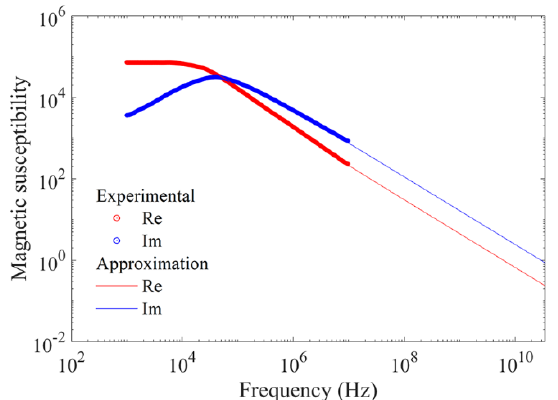
Figure 4. Frequency dependences of transmission and reflection coefficients: for the composite with 30% flakes in the frequency range from 26 to 38 GHz ( a ); for the composite with 15% flakes in the frequency range from 17 to 26 GHz ( b ).